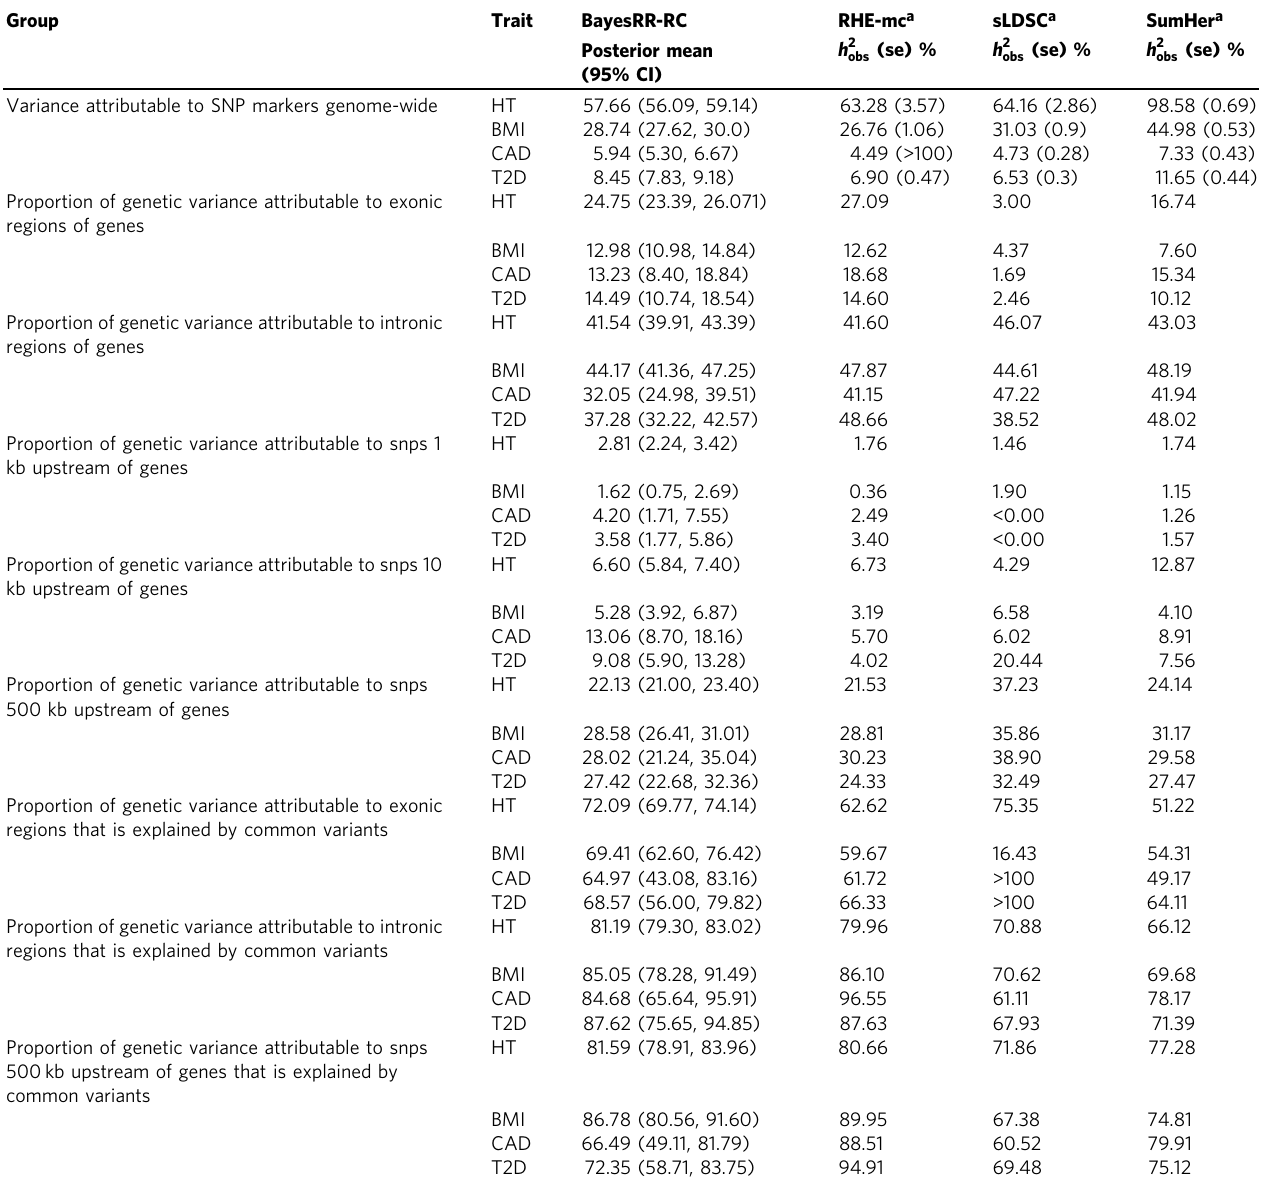
Table 1 Proportion of genetic variance attributable to different genomic regions for height (HT), body mass index (BMI), type-2 diabetes (T2D) and cardiovascular disease (CAD). Group